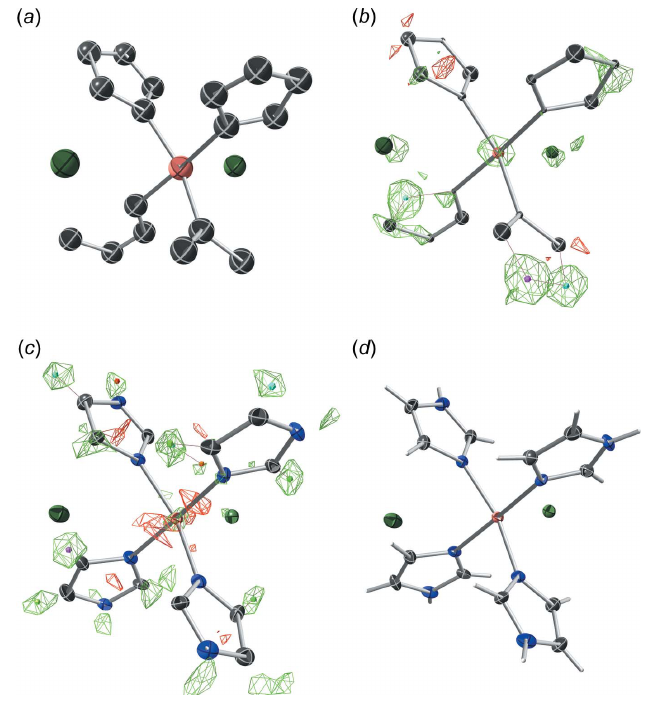
Figure 5 Snapshots of model building and refinement of XUBNIR. ( a ) Initial structure solution from SHELXD . ( b ) After isotropic refinement, three missing atoms are clearly visible as difference-map peaks, and the relative size of displacement spheres allow most carbon and nitrogen atoms to be distinguished. ( c ) After anisotropic refinement, all hydrogen atoms are clearly present in a difference map. ( d ) After inclusion of hydrogen atoms. Diagrams were generated using ShelXle (Hu¨bschle et al. ,